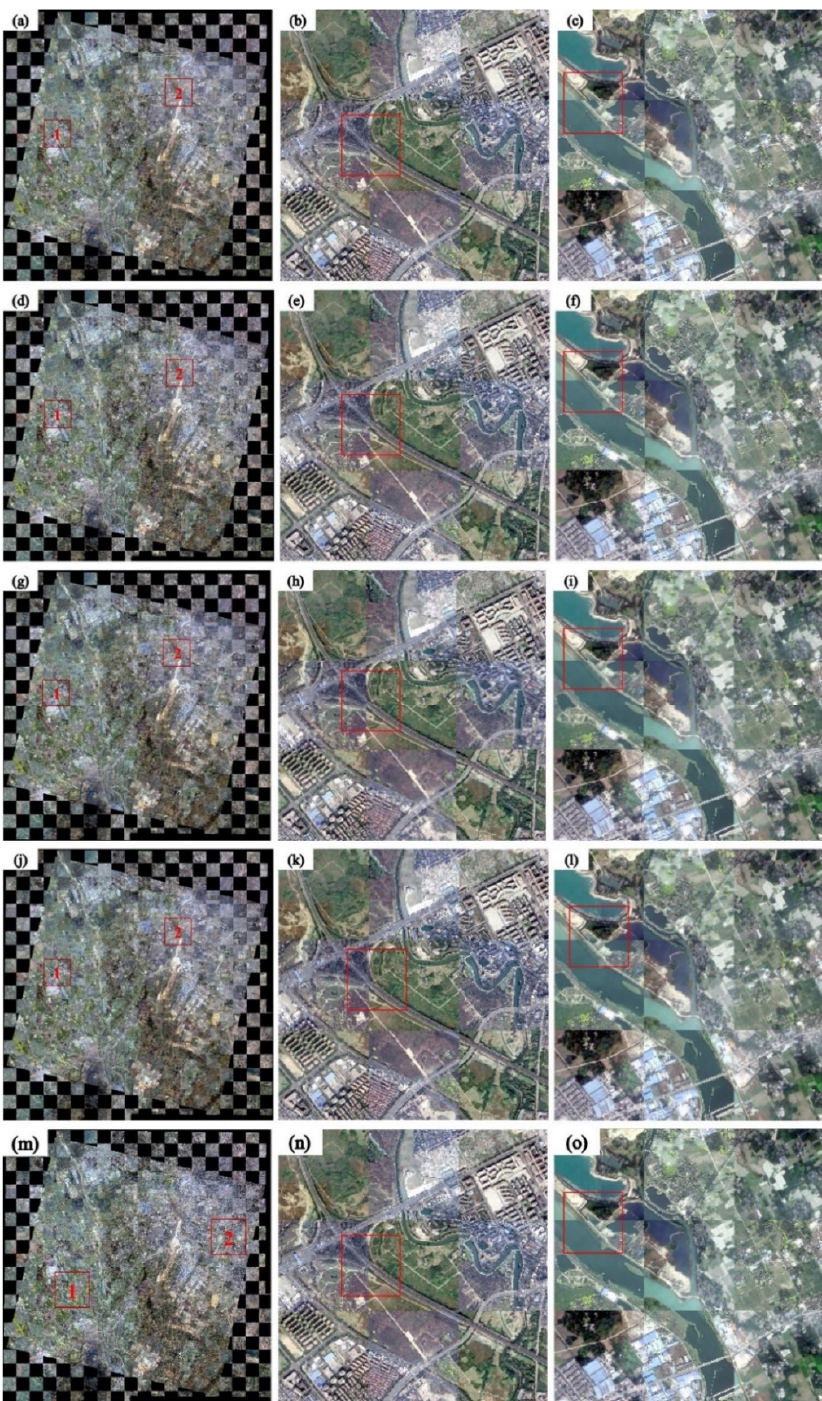
Figure 9. Checkerboard images for the P-A dataset. ( a ) Original image; ( b ) enlarged image of red box 1 in ( a ); ( c ) enlarged image of red box 2 in ( a ); ( d ) result for the proposed method; ( e ) enlarged image of red box 1 in ( d ); ( f ) enlarged image of red box 2 in ( d ); ( g ) result for the Patch-SIFT; ( h ) enlarged image of red box 1 in ( g ); ( i ) enlarged image of red box 2 in ( g ); ( j ) result for the SIFT; ( k ) enlarged image of red box 1 in ( j ); ( l ) enlarged image of red box 2 in ( j ); and ( m ) result for the SURF; ( n ) enlarged image of red box 1 in ( m ); ( o ) enlarged image of red box 2 in ( m ). The red boxes indicate the regions where noticeable differences can be observed.